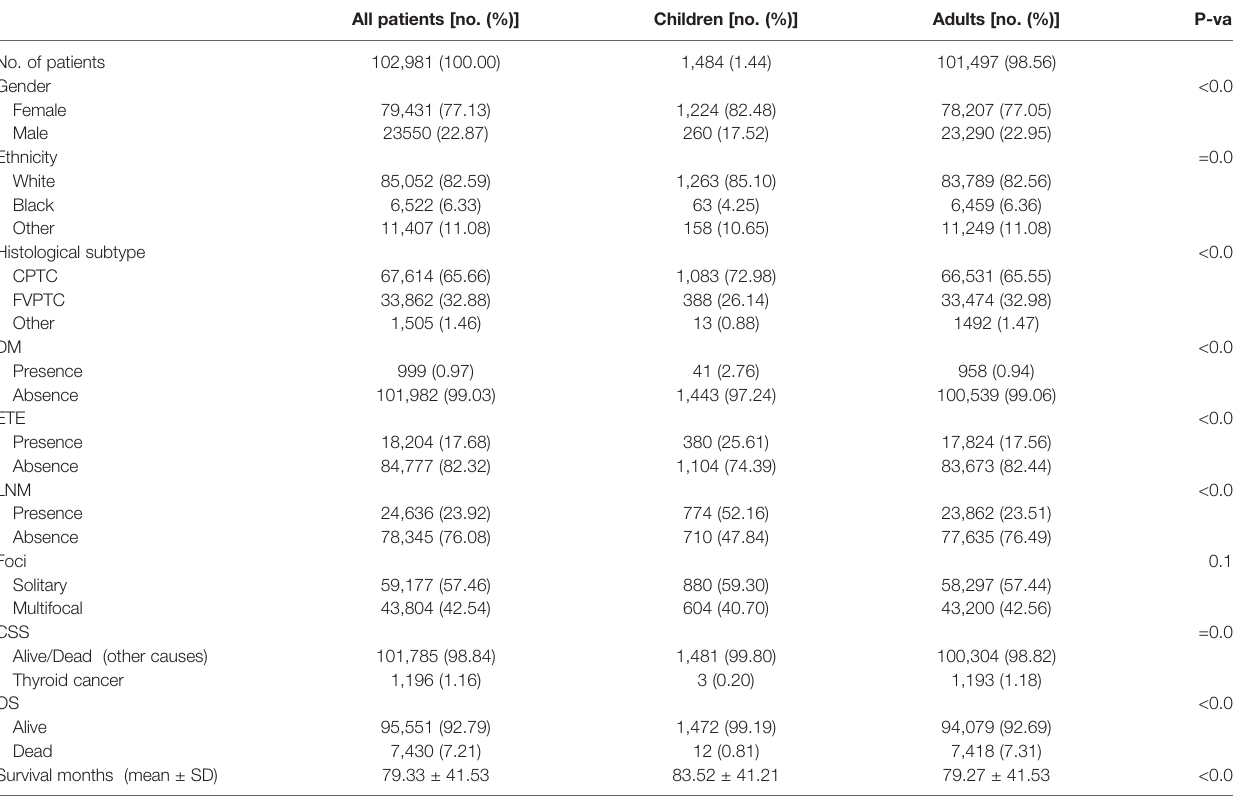
TABLE 1 | Baseline clinicopathological characteristics of patients with PTC. All patients [no.